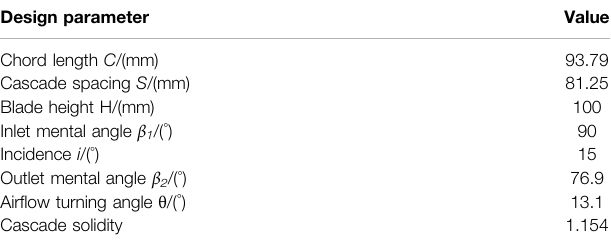
TABLE 1 | Cascade parameters. Design